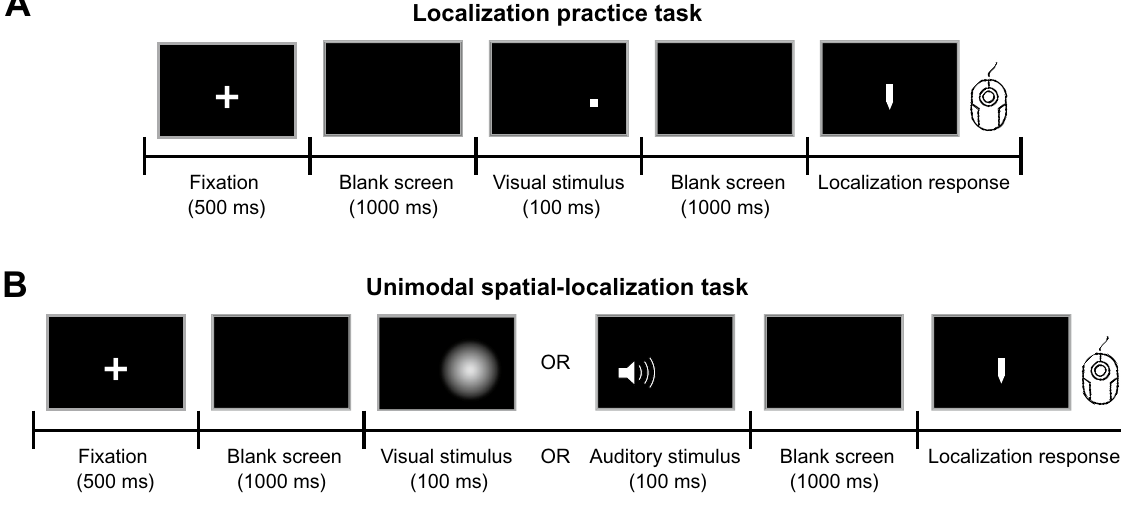
Figure 3. Experimental procedure: localization-practice and unimodal spatial-localization tasks, preparatory experiments 2 and 3. ( A ) Localization-practice task. Participants were presented with a small white square and used a visual cursor to indicate the stimulus’ horizontal location. ( B ) Unimodal spatial-localization task. Participants localized either a unimodal visual or auditory stimulus. Feedback was not provided for either